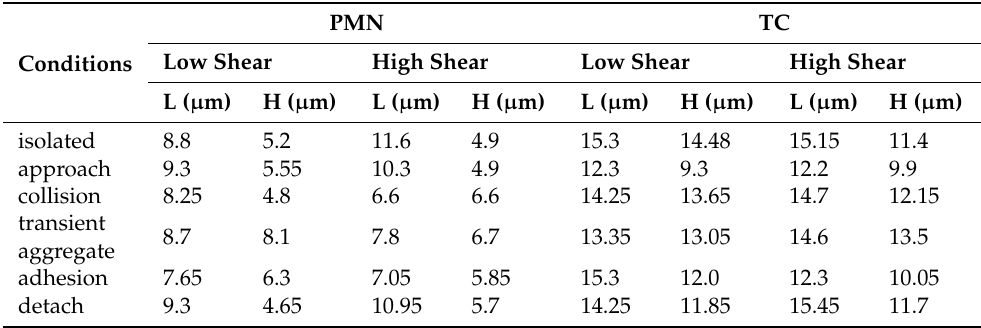
Table 1. Cell dimensions measured in sFg solution.